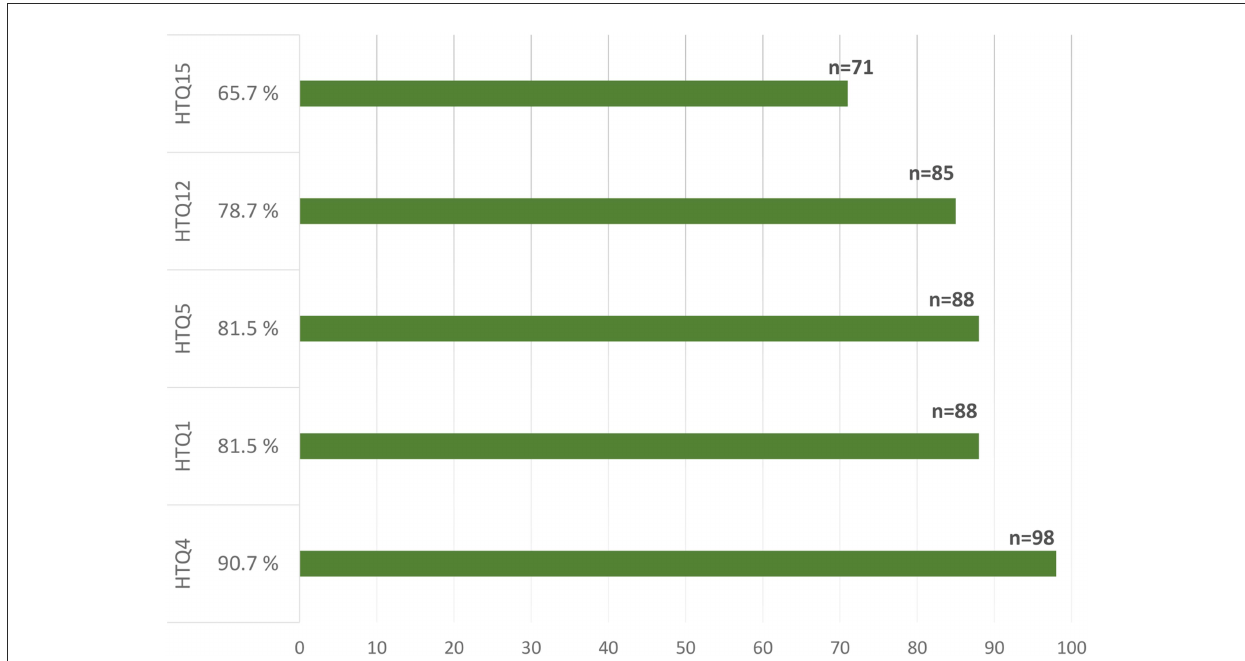
FIGURE1 HTQ1: “oppressed because of ethnicity, religion, or sect”; HTQ4: “property looted, confiscated, or destroyed”; HTQ5: “forced to leave hometown and settle in a different part of the country with minimal services”; HTQ12: “witnessed the desecration or destruction of religious shrines or places of religious instruction”; HTQ15: “witnessed the shelling, burning, or razing of residential areas or marshlands.”